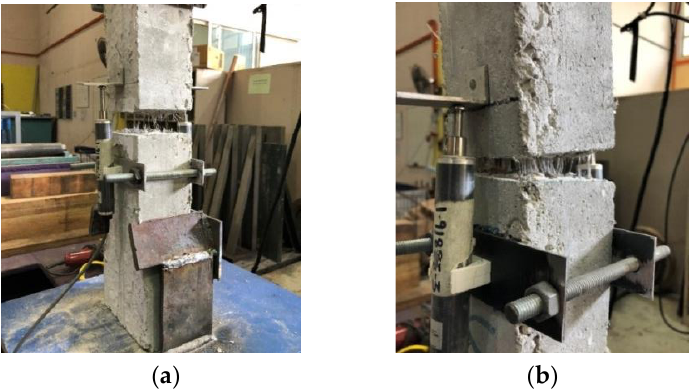
Figure 15. The fiber-bridging effect as shown in tension: ( a ) Uniaxial testing under tension for dog-bone specimens ( b ) Fiber-bridging effect during uniaxial tensile test.